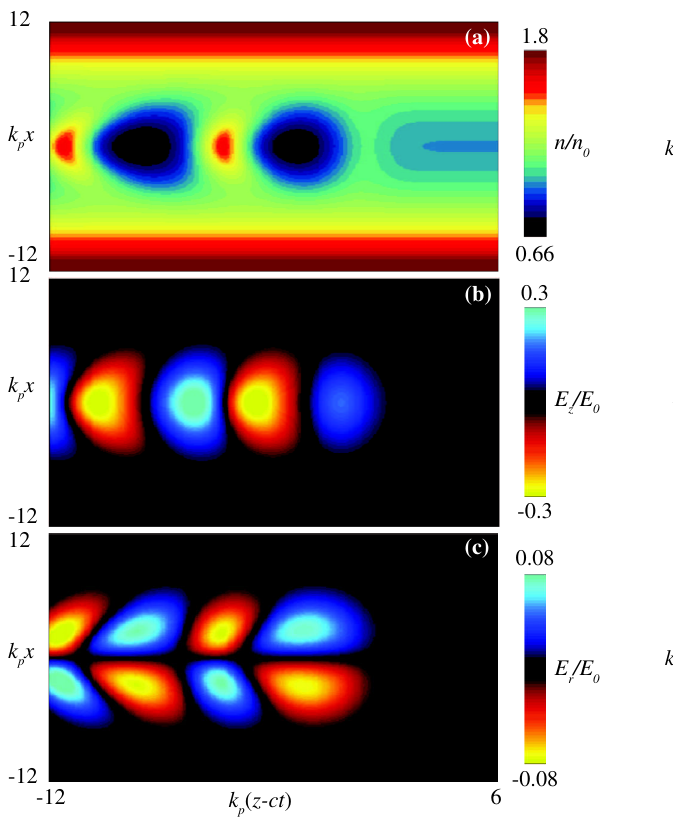
FIG. 1. Plasma wave excitation in the quasilinear regime: (a) electron density n=n (c) transverse electric field E r =E laser vector potential initially has the form a ¼ a exp ð(cid:1) r 2 =r 2 L (cid:1) z 2 = 4 L 2 Þ , with a 0 1 . Laser is propagating to the right [centered at k p ð z (cid:1) ct Þ ¼ 0 ] in a matched parabolic plasma density channel. Accessible phase regions of focusing and acceleration for both electrons and positrons are present.